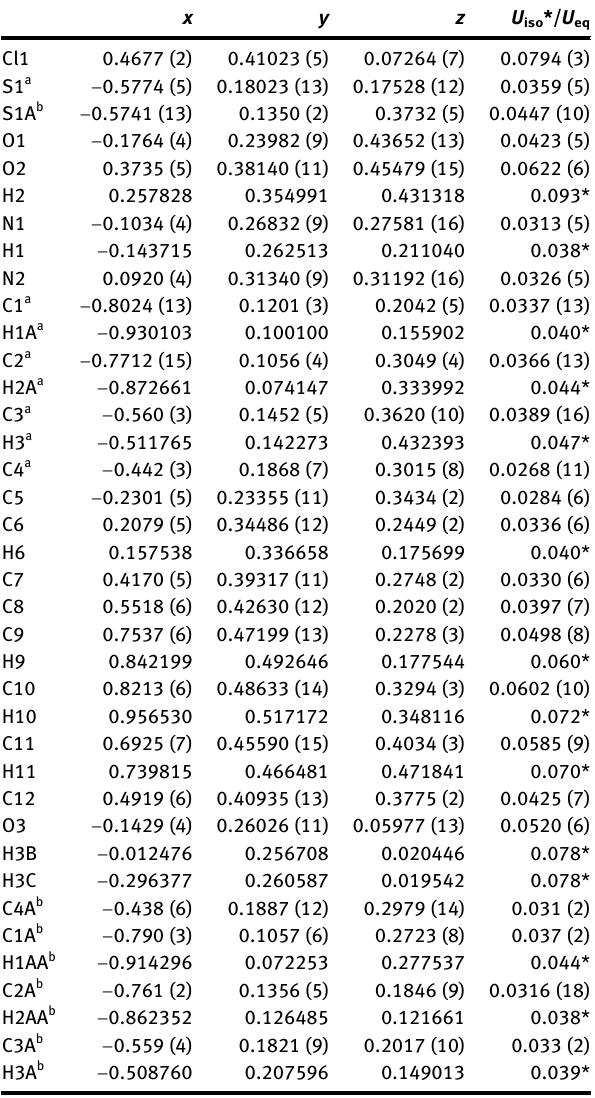
Table  : Fractional atomic coordinates and isotropic or equivalent isotropic displacement parameters (Å 